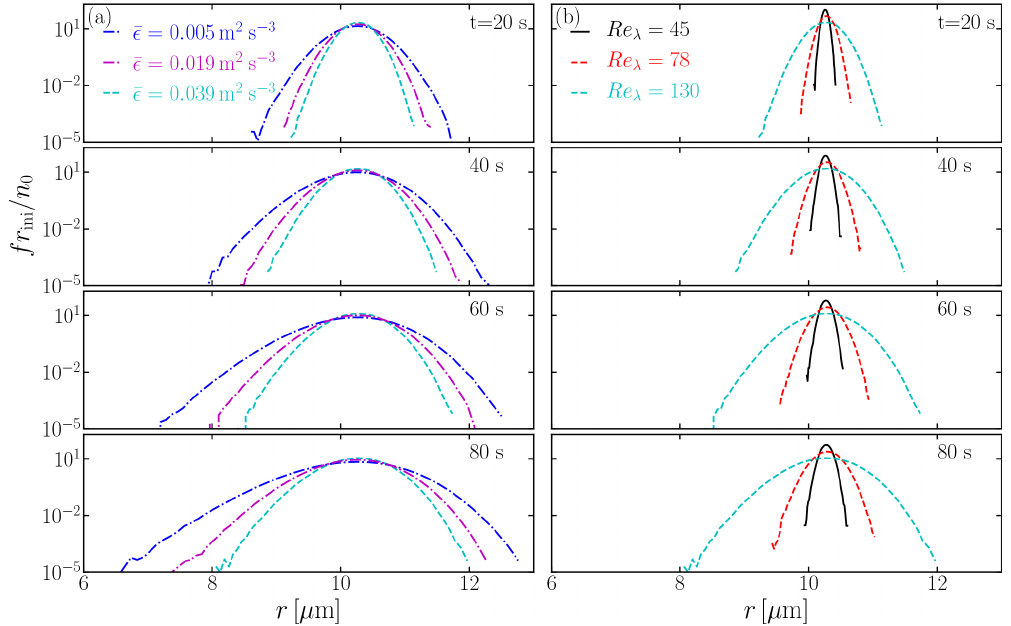
Figure 3. Comparison of the time evolution of droplet size distributions for different (a) (cid:15) at Re λ = 130 (runs C, D, and E in Table 2) and (b) Re λ at (cid:15) = 0 . 039m 2 s − 3 (runs A, B, and C in Table 2). Same simulations as in Fig.